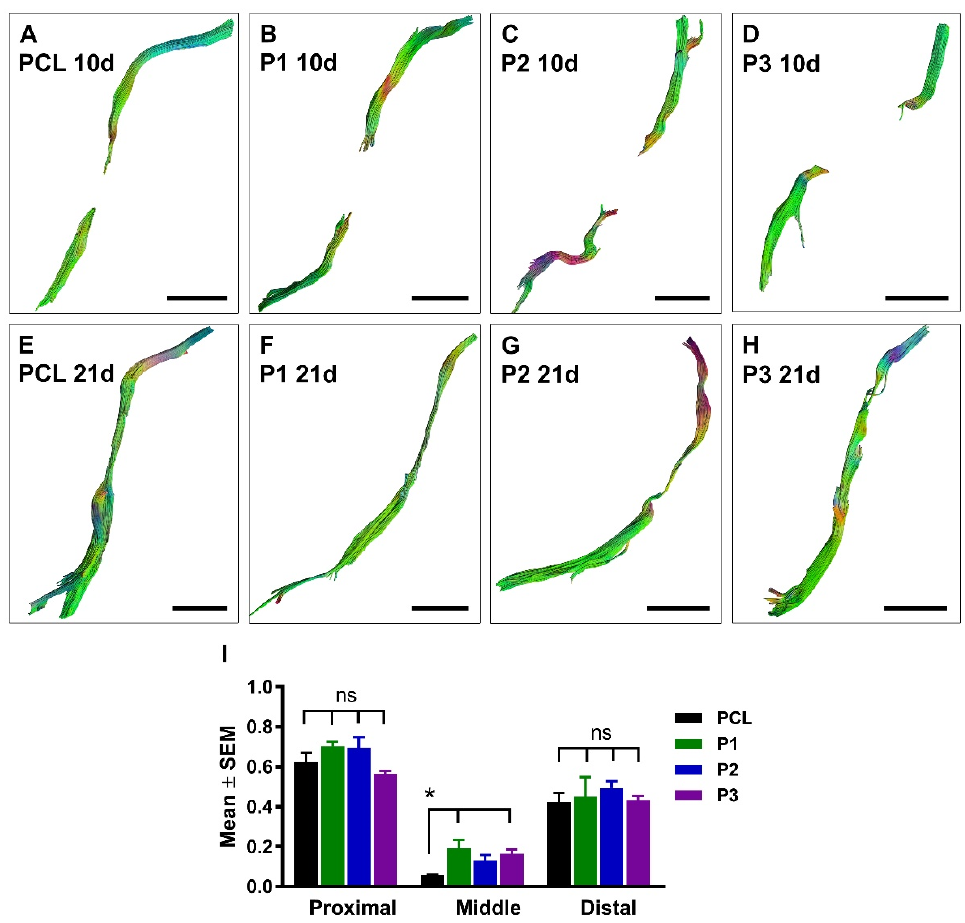
Figure 6. Diffusion tensor imaging of regenerating axons in the conduits. Representative axial DTI images at 10 days ( A – D ) and 21 days ( E – H ) after sciatic nerve injury and repair with empty PCL conduit or PCL conduit filled with P1, P2, or P3 hydrogel. Histogram in ( I ) shows quantification of the fractional anisotropy measured in proximal, middle, and distal ROIs at 21 days after nerve injury and repair (PCL, n = 5, P1, n = 5, P2, n = 7, and P3, n = 7). p < 0.05 is indicated by * (PCL versus P1 and P3 hydrogels); ns, not significantly different. Scale bar, 5 mm.